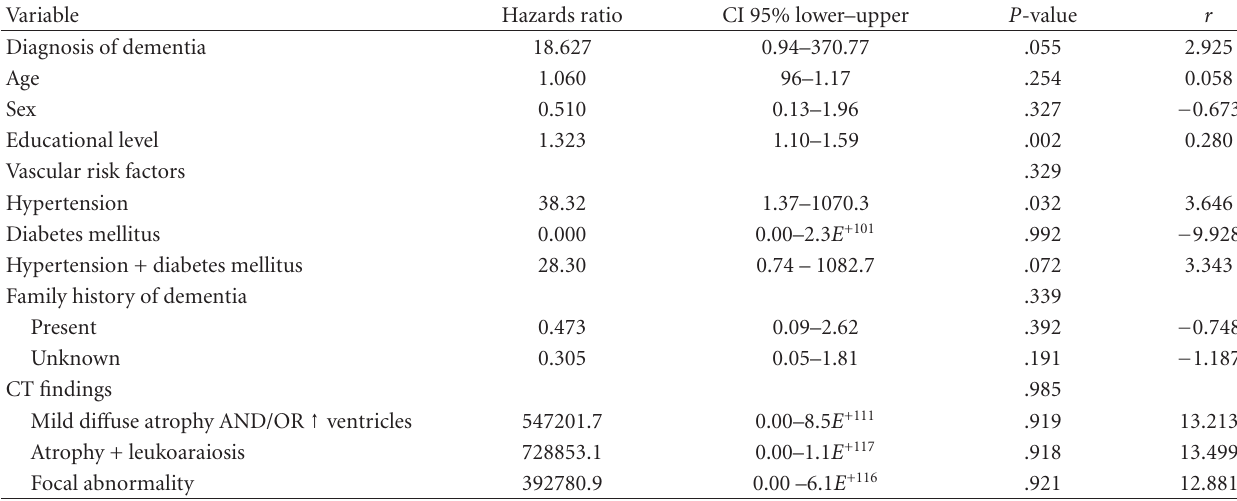
Table 3: Predictive factors in Cox Proportionate Hazards Models, including diagnosis of dementia, age, educational level, sex, family history of dementia, CT scan findings, and vascular risk factors, for the progression of dementia (worsening of severity according to CDR